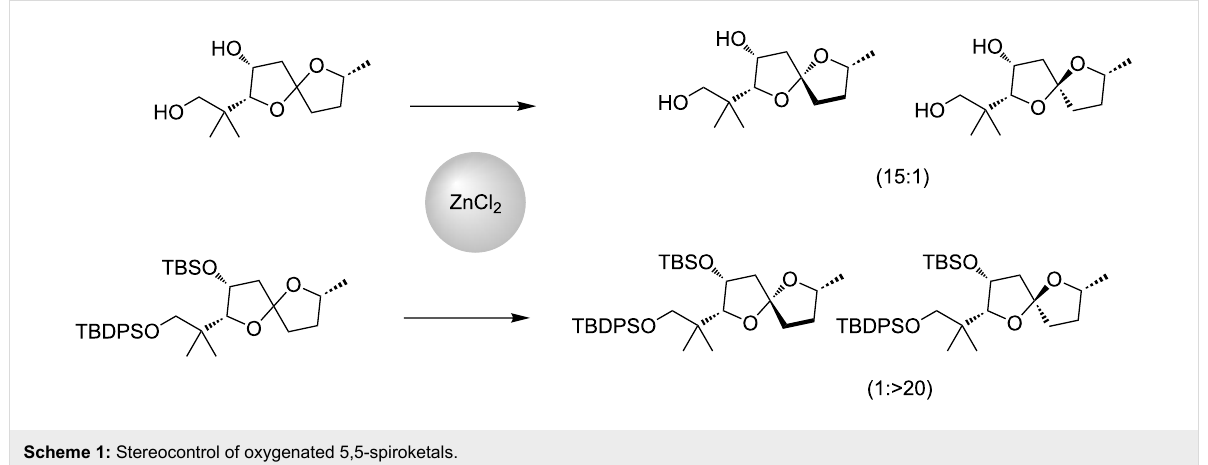
Scheme 1: Stereocontrol of oxygenated 5,5-spiroketals.